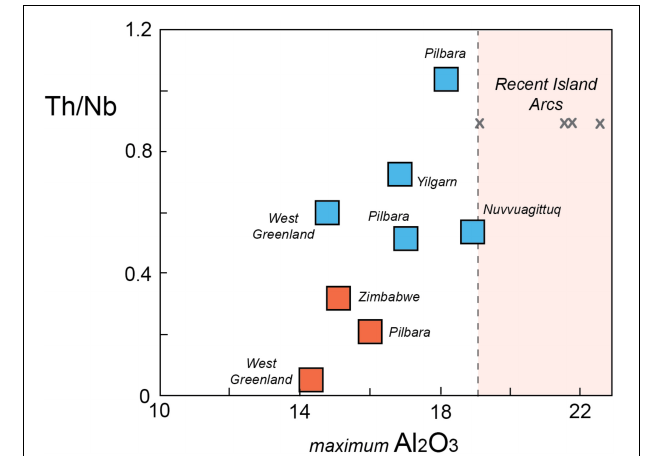
FIGURE 6 | Variations of mean Th/Nb values for the magmatic suites plotted in Figure 5 , with maximum Al 2 O 3 . The Barberton is not plotted because the rocks are predominantly komatiites, and the Island arc suites are from the Marianas, Tonga, Aleutians and the Lesser Antilles (from the database GEOROC: http://georoc.mpch-mainz.gwdg.de/georoc), plotted at an arbitrary Th/Nb =